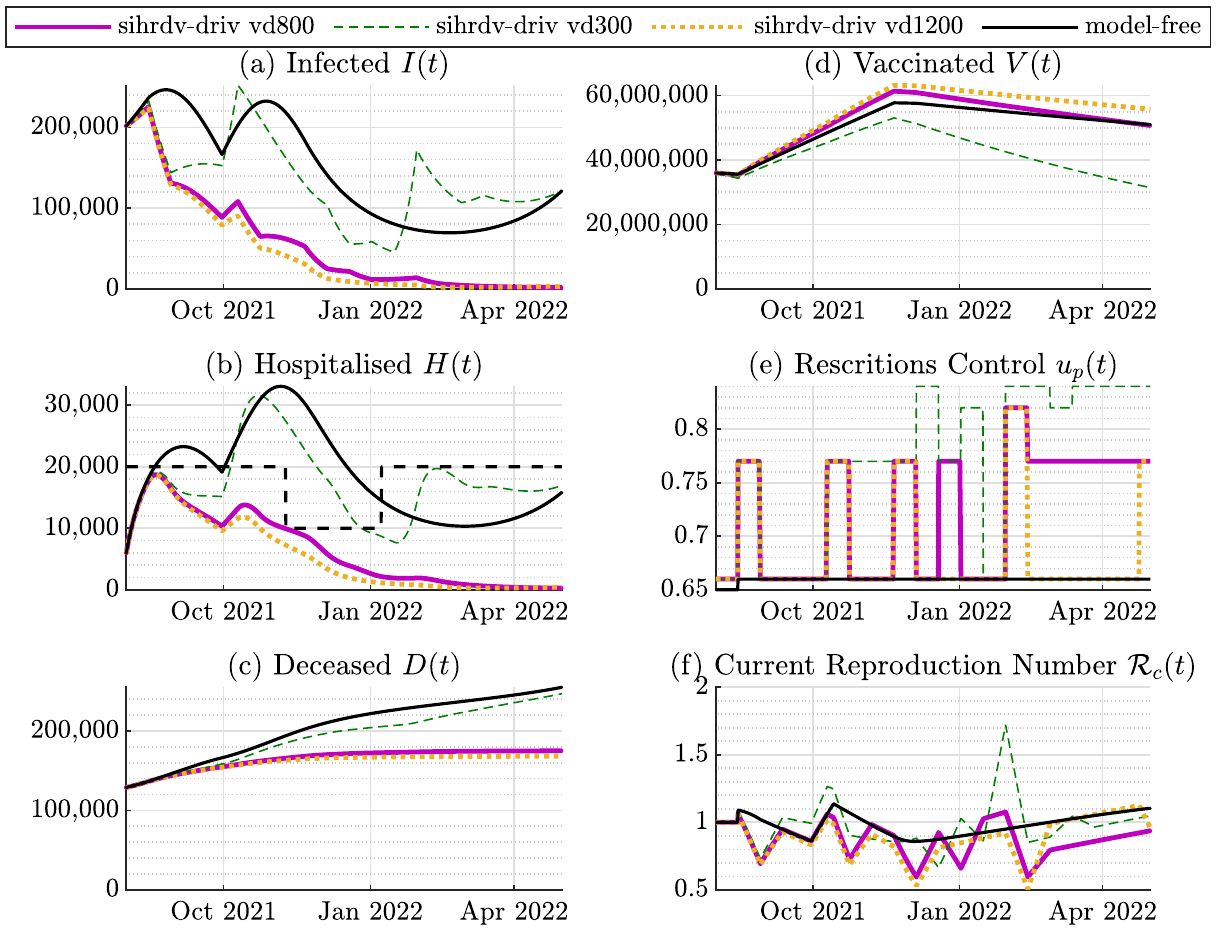
Figure 5. Perspective Test August 2021-May 2022. A new variant with R 0 = 10 appears in October 2021. The purple line named sihrd-driv vd800 represents our SIHRD-V model-driven results with a vaccination immunity decay time constant of 800 days. We also include the SIHRD-V model-driven results with a vaccination immunity decay time constant of 300 days (the green dashed line named sihrd-driv vd300), and of 1200 days (the orange dotted line named sihrd-driv vd1200). The black line represents the model-free intervention policy, i.e. without any restrictions adjustment. The black dashed line represents the chosen time-varying threshold for the hospitalised population. The hospitalised population remains below the maximum accepted time-varying threshold with the use of our intervention strategy.